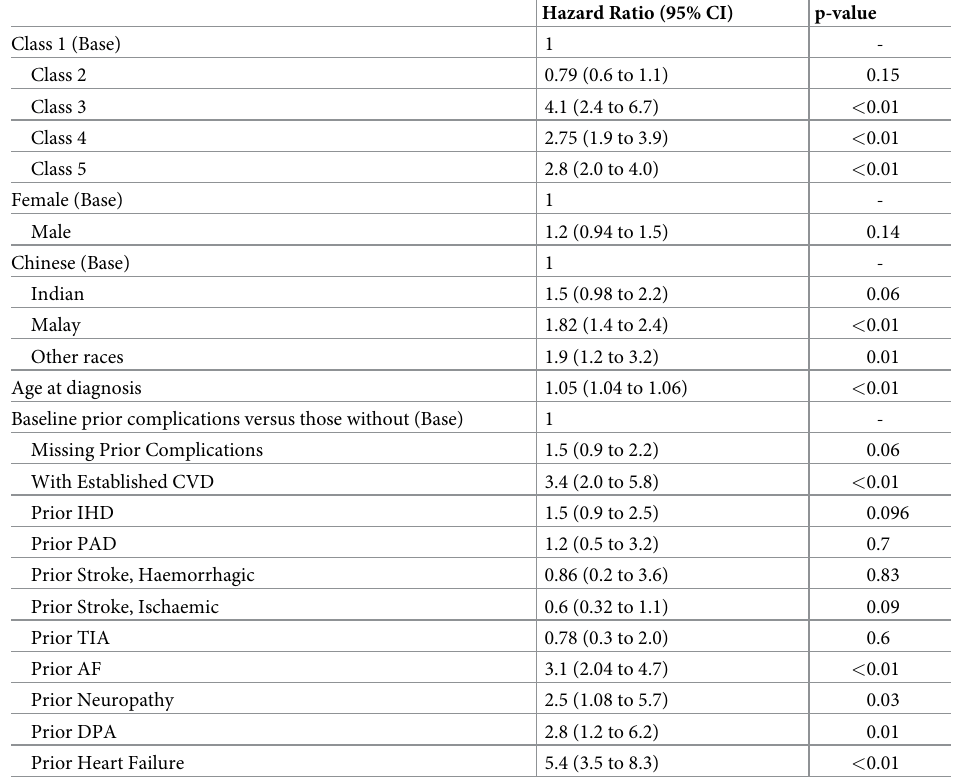
Table 5. Summary of associations between HbA1c trajectories and HHF after adjusting for multiple risk